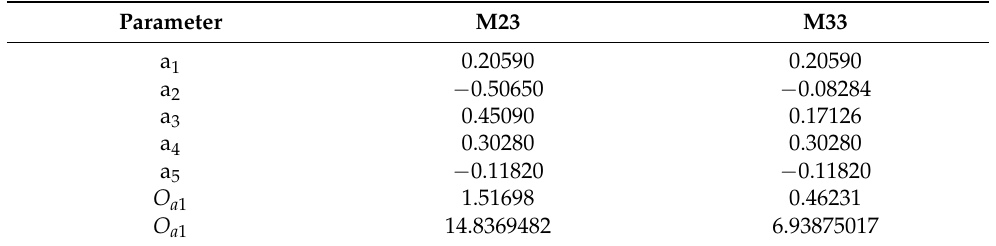
Table 4. Calibrated values of the parameters of the black-box net photosynthesis model. Offset values O a 1 and O a 2 were calculated for Capsicum annuum L. and Capsicum chinense Jacq., respectively.